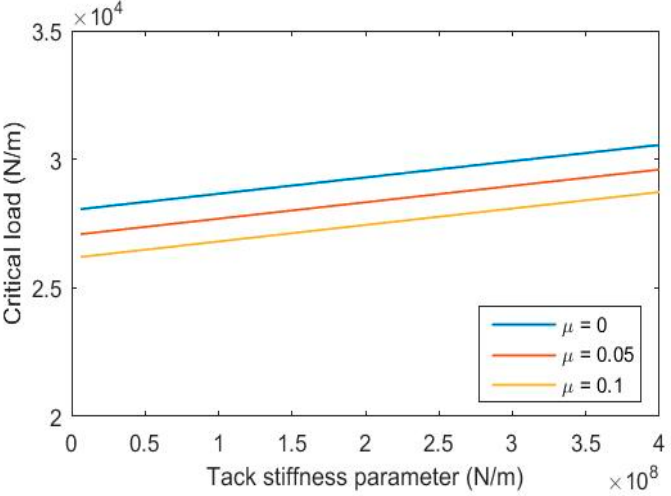
Figure 12. Critical buckling load variations with respect to tack stiffness parameter for different initial defect coefficients.